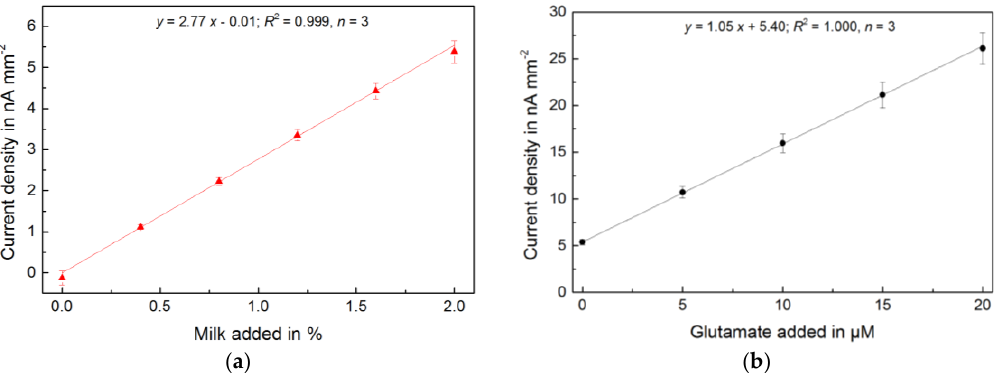
Figure 3. ( a ) Glutamate signal measured from successive additions of milk samples to PBS; ( b ) Subsequent in-line glutamate calibration in the presence of milk showing high linearity.